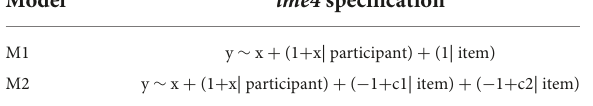
TABLE 2 lme4 specification of GLMMs in this study.